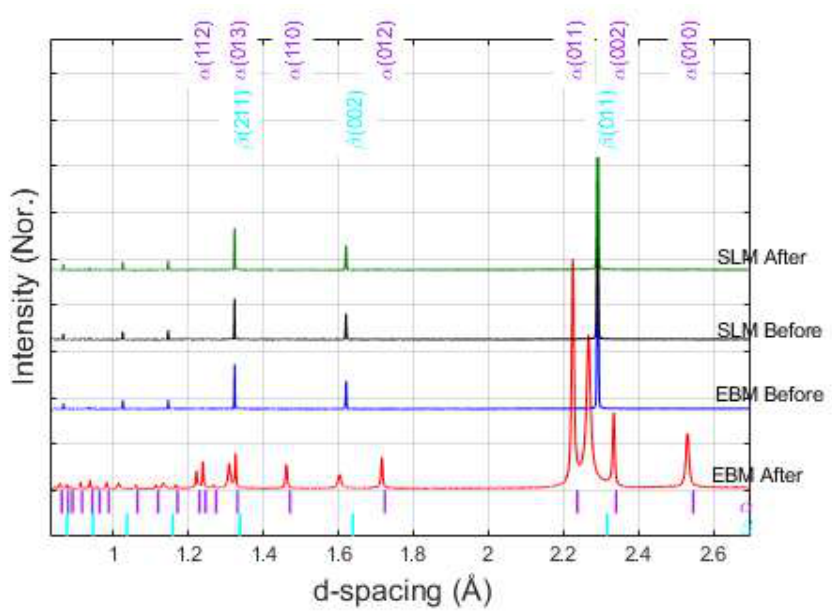
Figure 4. Diffraction pattern of powders before and after the process. These color-coded tick marks under the diffractogram correspond to the expected peak positions of α- and β-Ti phases reported in the Inorganic Crystal Structure Database (ICSD) [27] (ICSD reference number of α-phase is 191187 and β-phase is 653278).